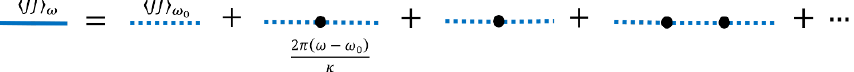
and . Dashed blue lines correspond to JJ JJ (cid:31) (cid:30) ω 0 (cid:31) (cid:30) ω , and black vertices to π ( ω − ω 0 ) (along with the corresponding JJ κ (cid:31) (cid:30) ω can be defined as (cid:30) JJ (cid:29) ω ω JJ (cid:30) (cid:29) ω 0